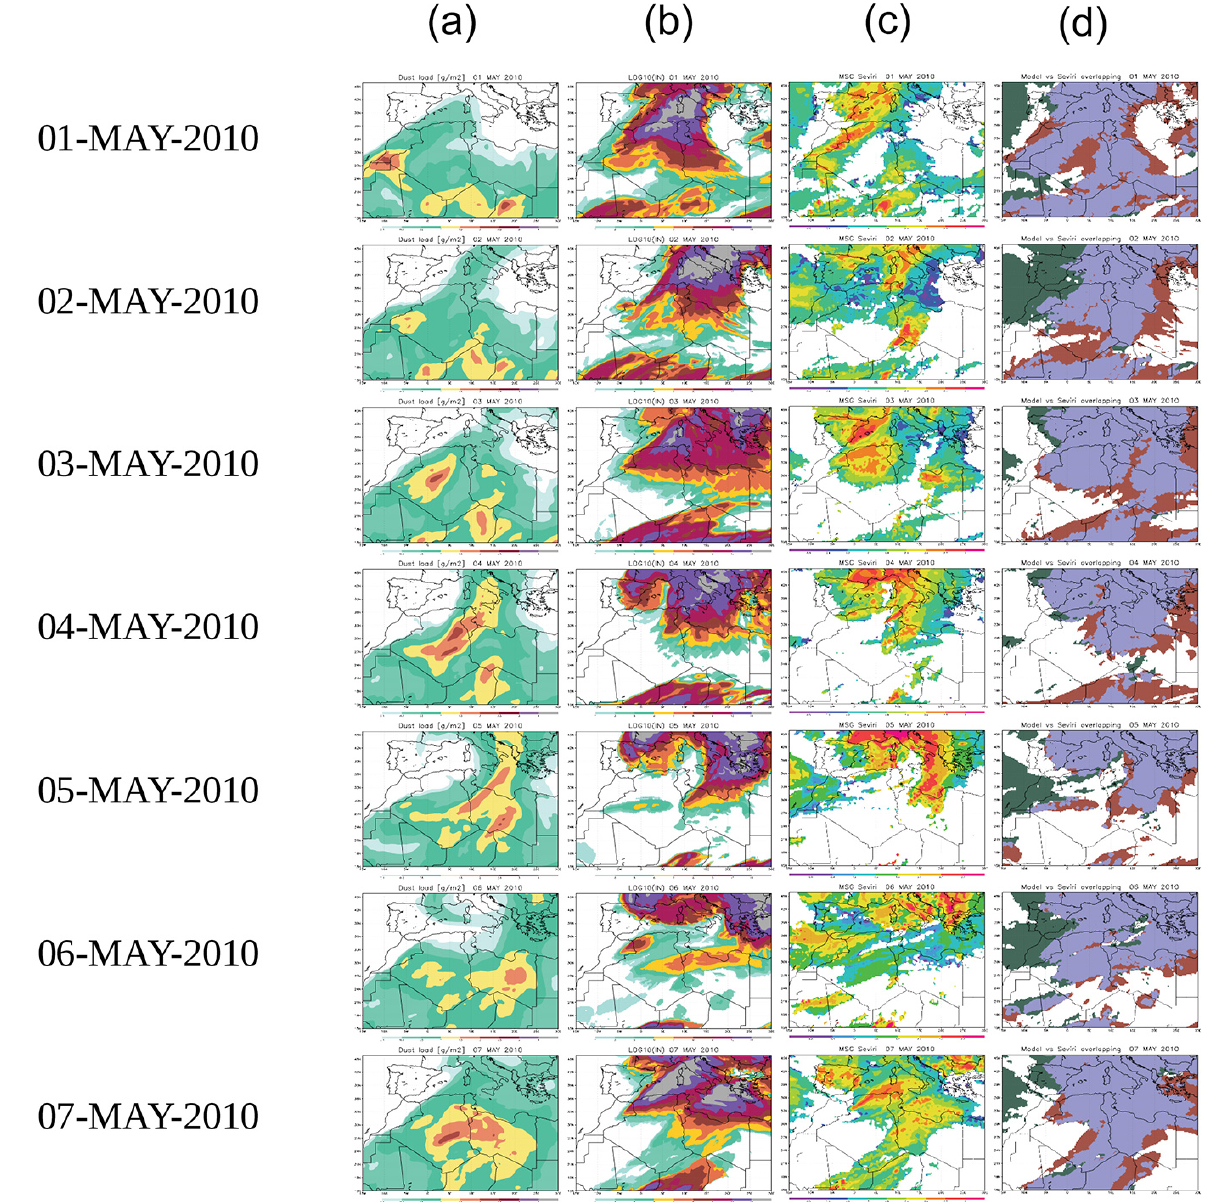
(Ferrier et al., 2002); and the parameterization of convec- tion clouds (Janjic, 1994, 2000). The initial and boundary atmospheric conditions for the NMME model have been up- dated every 24 h using the ECMWF 0.5 ◦ analysis data. The concentration was set to zero at the “cold start” of DREAM launched 4 days before the period to be studied, thus permit- ting the model to be “warmed up”, i.e. to develop a meaning- ful concentration field at the date considered as an effective model start. After that point of time, 24 h dust concentration